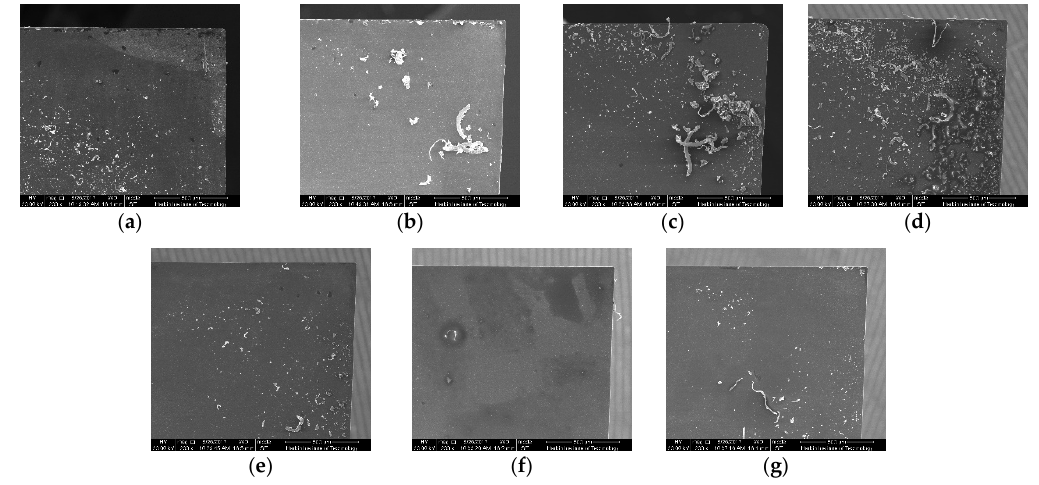
Figure 7. The morphology of mills obtained by Scanning Electron Microscopy (SEM). ( a ) Test No. 1; ( b ) Test No. 2; ( c ) Test No. 3; ( d ) Test No. 4; ( e ) Test No. 5; ( f ) Test No. 6; ( g ) Test No. 7.